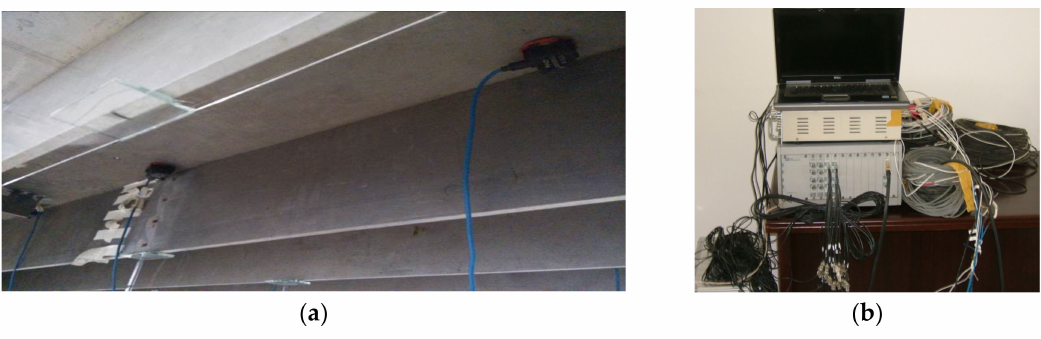
Figure 4. Photographs of the sensing system: ( a ) accelerometers; ( b ) data acquisition